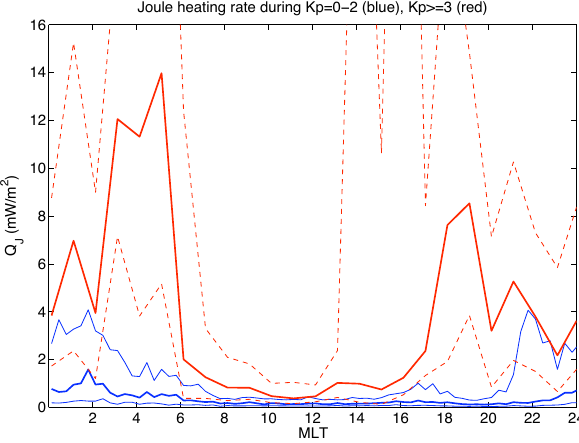
Fig. 9. Electric field northward component in geomagnetic coordi- nates, same format as Fig. 4.